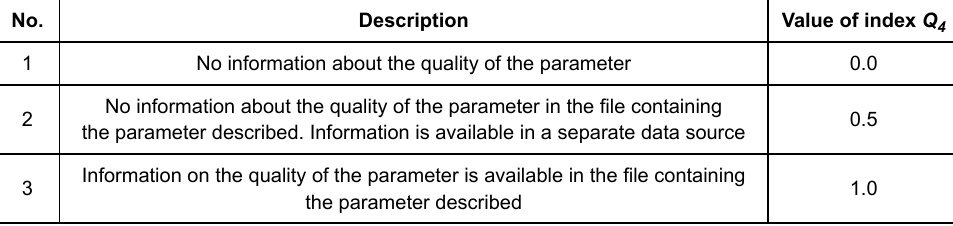
Table 4. Index of information availability on the quality of described parameter Q